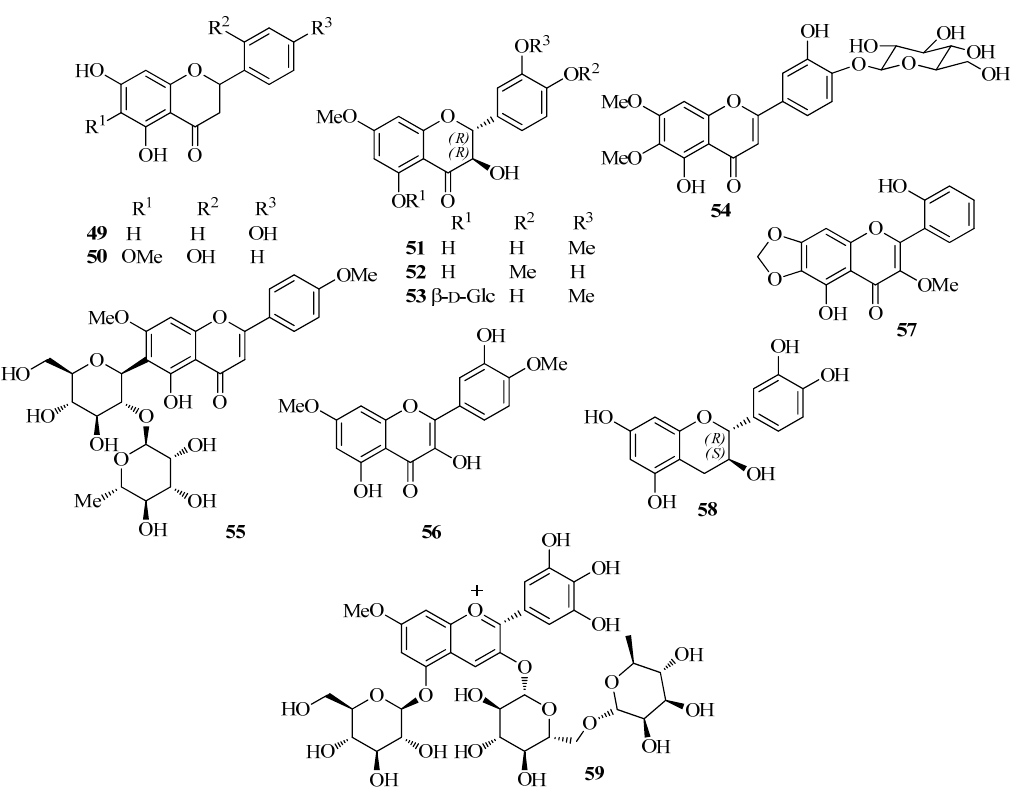
Figure 3. Characteristic flavonoids other than isoflavones isolated from Iris germanica .